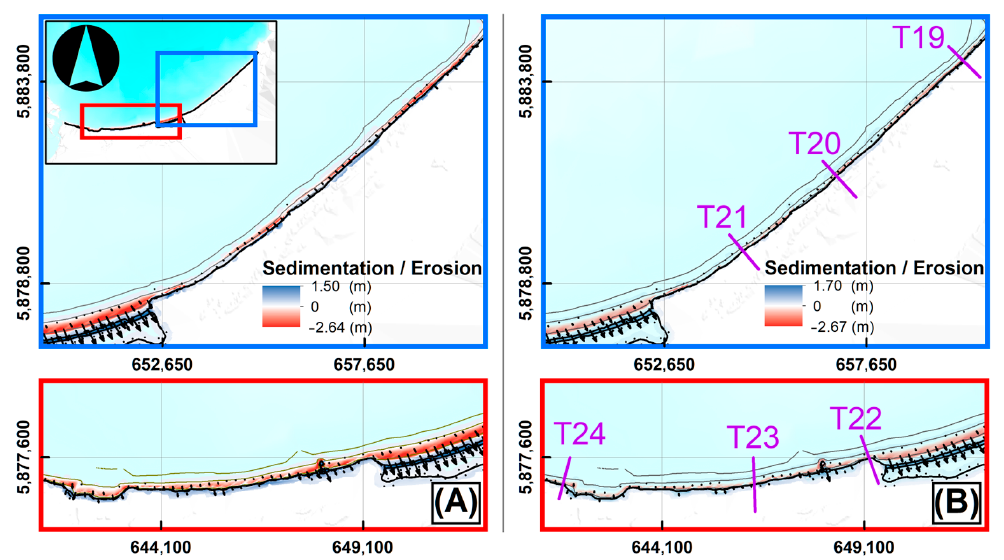
Figure 15. Morphological changes in Arauco during: ( A ) winter and ( B ) summer. Arauco beach is divided into two zones: east (blue box) and west (red box), as in Figure 13. T19–T24 are control transects at Arauco beach.